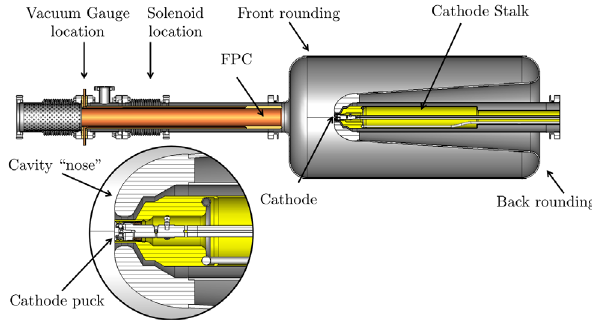
FIG. 1. Simplified geometry of the SRF